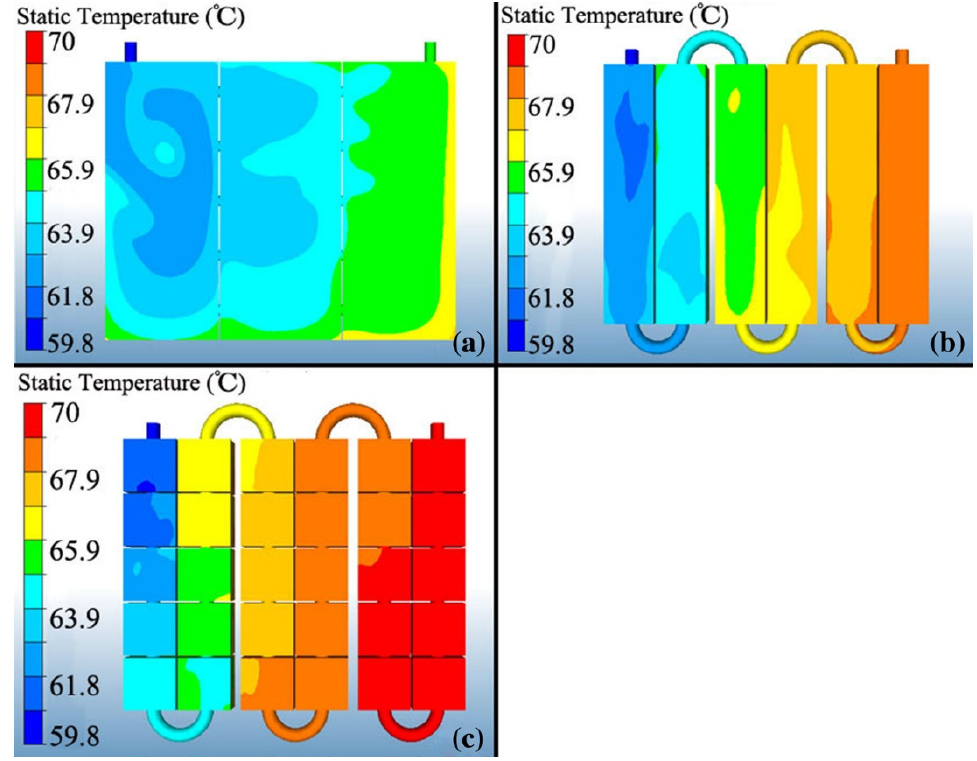
Figure 2. Predicted temperature field of the TEG cooling units: ( a ) Plate-shaped; ( b ) Stripe-shaped; ( c ) Diamond-shaped. Reprint with permission [50]; Copyright 2021, Springer Nature.